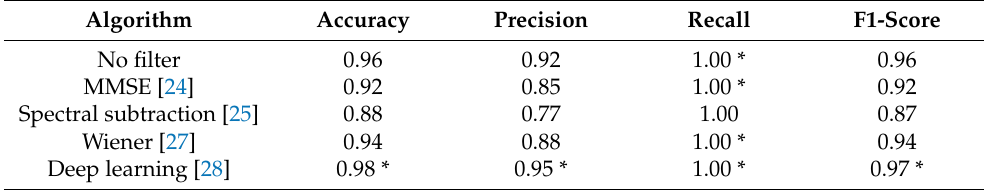
Table 6. White Noise SNR − 10. * is the best result for each particular measure.